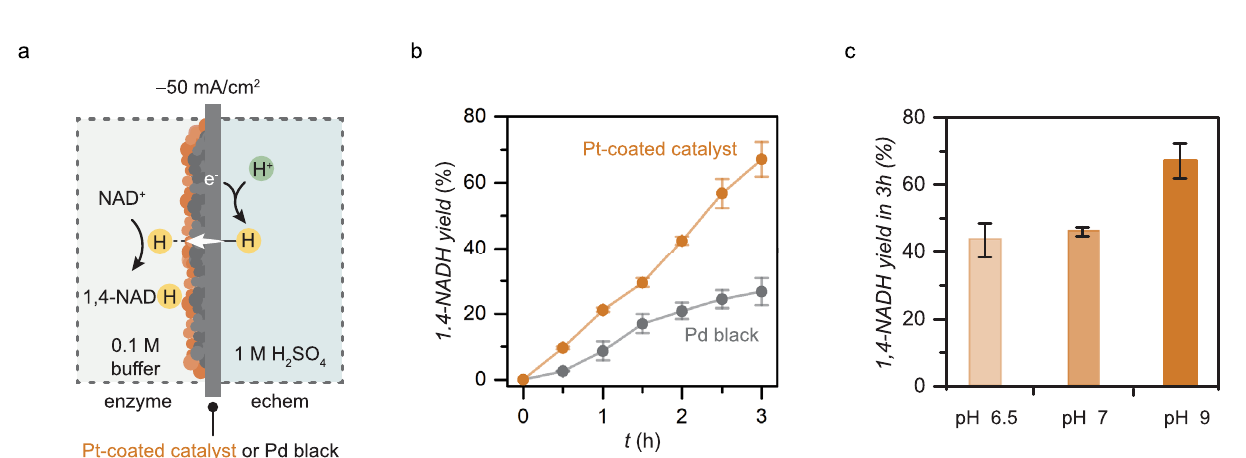
platinum anode, a Ag/AgCl reference electrode, and the palladium cathode/mem- brane. Catalyst (Pd black or Pt-coated) is coated on the side of the membrane exposed to the enzyme